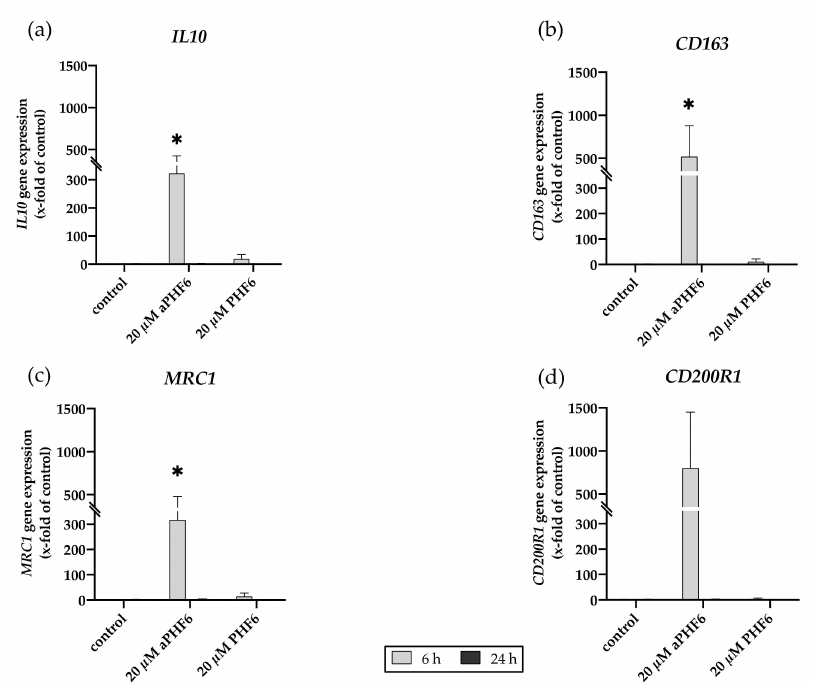
Figure A5. Aggregated PHF6 induced gene expression of M2 markers. ( a ) IL10 , ( b ) CD163 , ( c ) MRC1 , and ( d ) CD200R1 gene expression after 6 and 24 h of aPHF6 treatment. * p < 0.05.